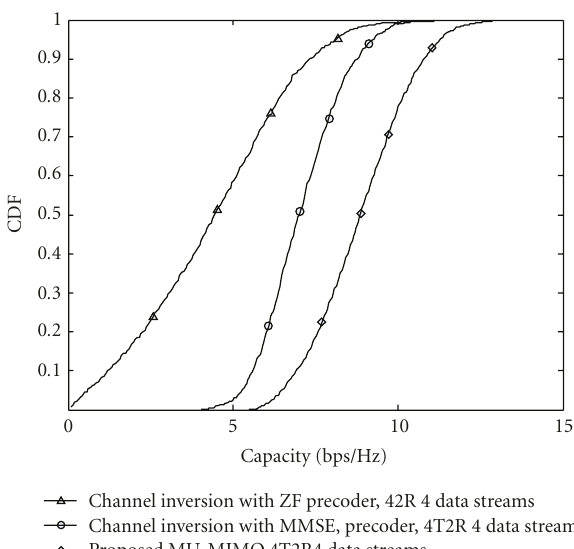
Figure 3: The system capacity CDF comparison of the two